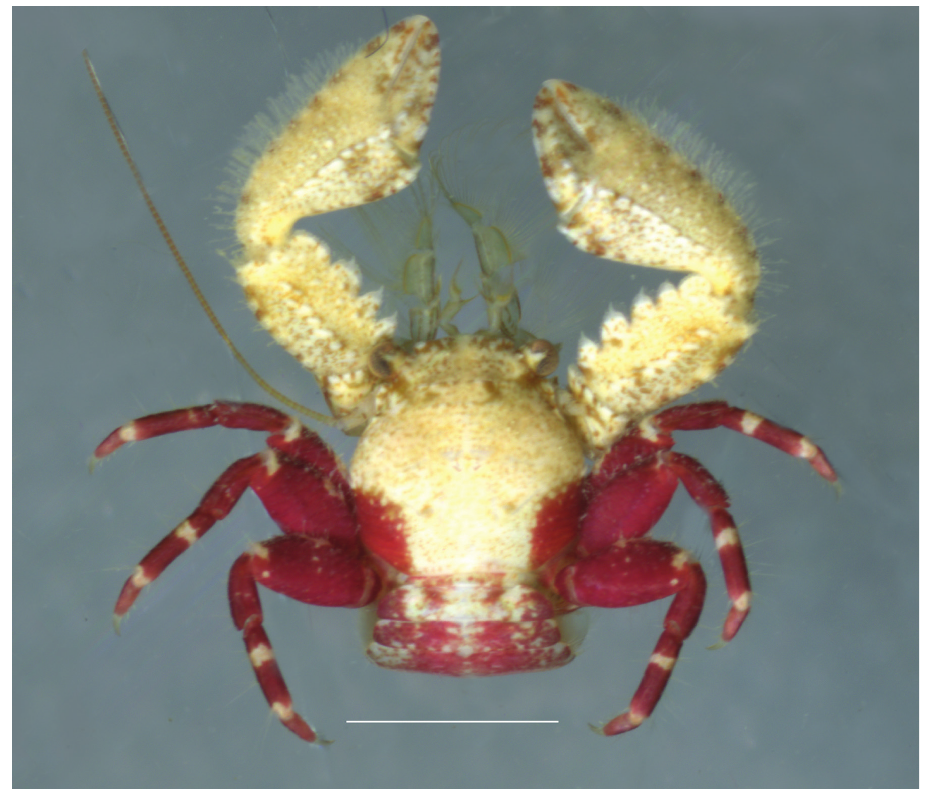
Figure 4. Petrolisthes aegyptiacus Werding & Hiller 2007, female, Red Sea, Egypt, Dahab. Scale bar: 3 mm.